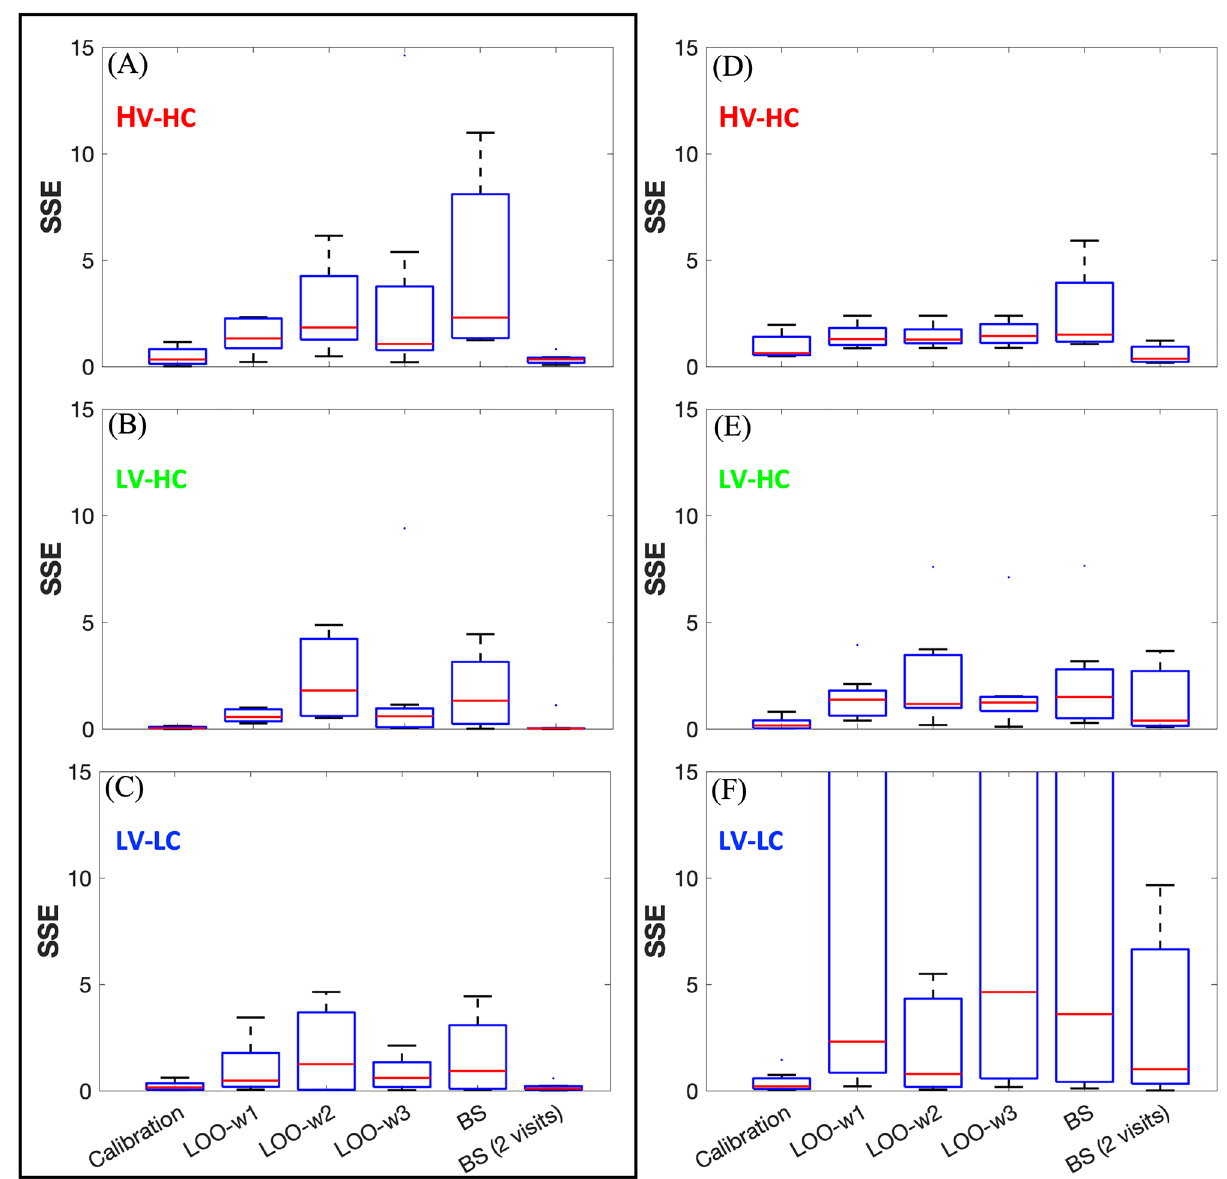
Figure 7. Comparing errors between predictions cross all rat datasets. ( A - C ) display the SSE distributions for six different prediction approaches for the HV-HC, LV-HC, and LV-LC habitats, respectively, for the control rat cohort (black rectangle). From left to right within each panel, the boxplots are model calibration, leave-one-out (LOO) with the initial tumor volume as the weighting scheme (LOO-w1), LOO with the initial tumor habitat composition as the weighting scheme (LOO-w2), LOO with the initial HV-HC volume as the weighting scheme (LOO-w3), bootstrapping (BS) with no data updating, and bootstrapping with two visits (BS (2 visits)). Bootstrapping with two visits yielded significantly lower error than the other four methods ( p < 0.01) in the HV-HC and LV-HC habitat growth predictions. Furthermore, bootstrapping with two visits showed no significant differences in error when compared to the direct calibrations. ( D - F ) are the analogous results for the treated rat cohort. Similarly, bootstrapping with two visits yielded significantly lower SSEs compared to the remaining prediction methods in the HV-HC habitat growth predictions. SSEs in ( F ) were significantly higher than the SSEs in the remaining clusters, where the SSE distribution from the LOO-w2 had the lowest median and lowest interquartile range and outlier value. To provide an understanding of the anomalous ranges in panel ( F ), we report that the 75th percentile of LOO-w3 and BS did not exceed 30, whereas this value for LOO w1 was